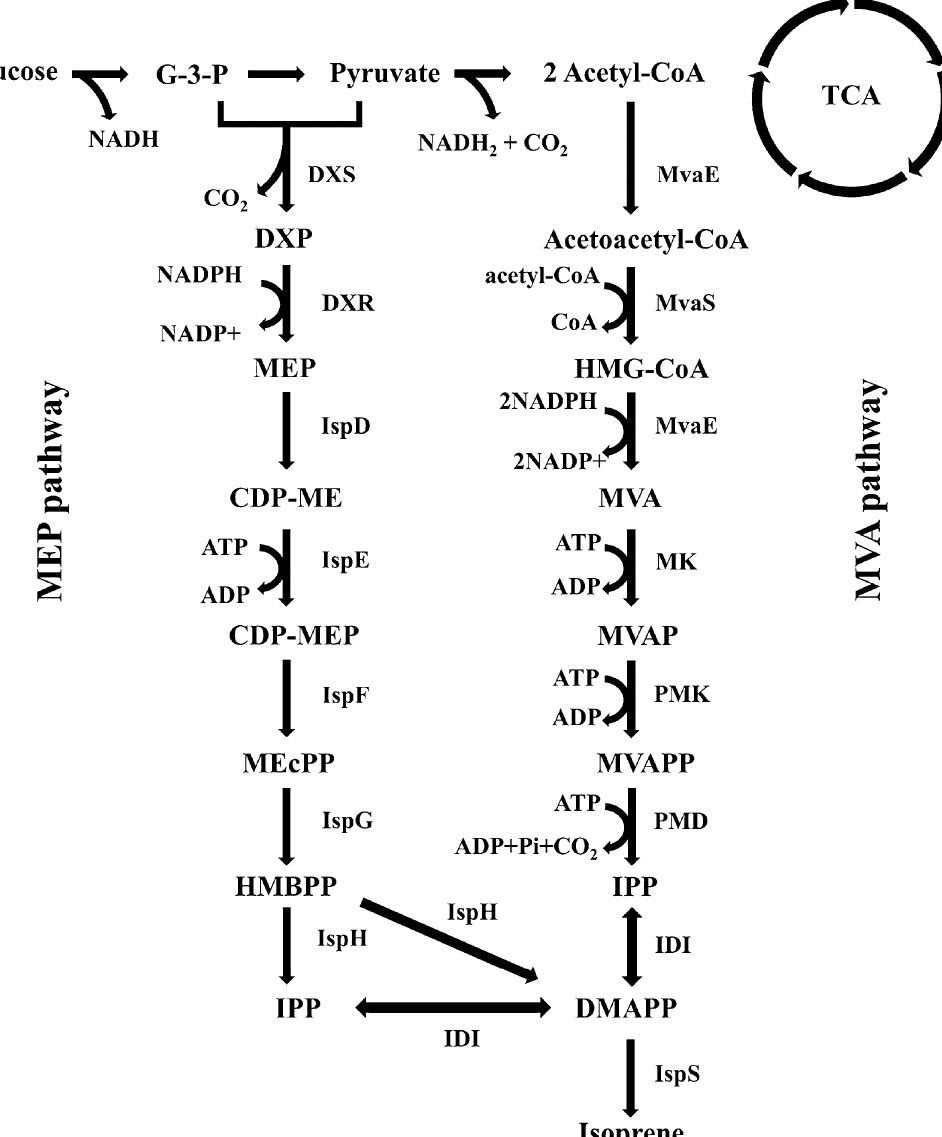
and the plastids of higher plants. Abbreviations: CDP-ME, methylerythritol cytidyl diphosphate; DXP, 1-deoxy- D-xylulose 5-phosphate; DXR, DXP reductoisomerase; DXS, DXP synthase; HMBPP, 4-hydroxy-3-methyl- butenyl-1-diphosphate; IPP, Isopentenyl diphosphate; IDI, IPP:DMAPP isomerase; MEcPP, 2- C -methyl-D- erythritol-2,4-cyclodiphosphate; MK, mevalonic acid kinase; PMD, phospho-mevalonate decarboxylase; PMK, phosphomevalonate kinase; DMAPP, dimethylallyl diphosphate; HMG-CoA, hydroxymethylglutaryl-CoA; MVA, mevalonic acid; MVAP, phosphomevalonic acid; MVAPP, diphosphomevalonic